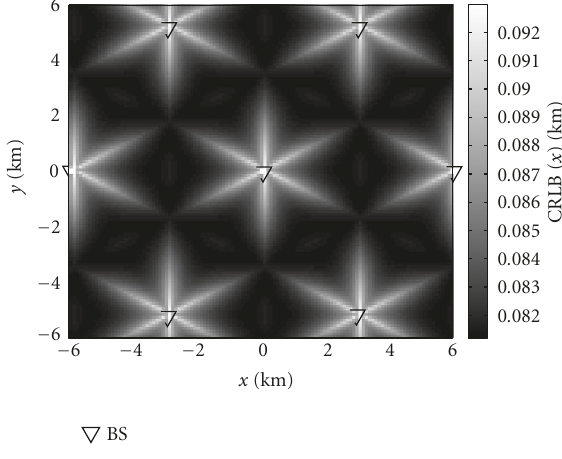
Figure 8: CRLB( x ) for σ n = 0 . 1km, R = 3km, N BS = 4.